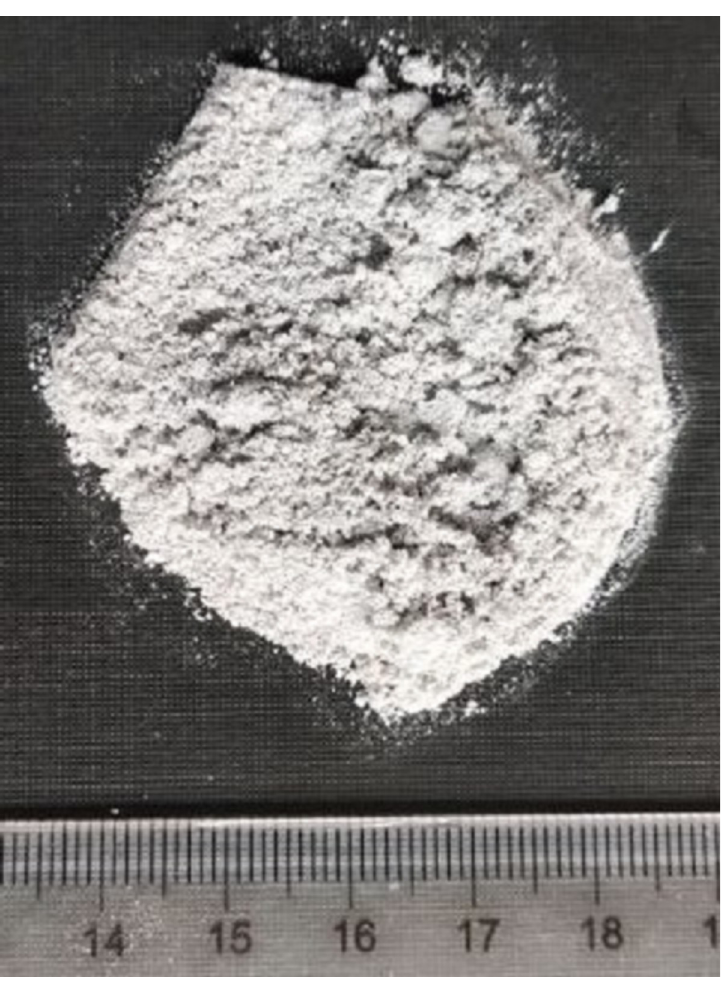
Fig 2. The carbide slag used in the study. Because carbide slag contains a large amount of calcium hydroxide, it has strong hygroscopicity, so it needs to be dried before use. After drying and dehydration, it was crushed by soil milling and passed through a 0.075 mm square hole